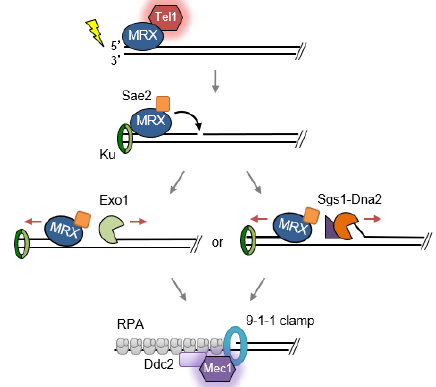
Figure 1. Damage recognition, end resection, and checkpoint activation. The Mre11-Rad50-Xrs2 (MRX) complex detects double-strand breaks (DSBs) and binds to the break ends (only one end is shown). Xrs2 recruits Tel1 and checkpoint signaling is activated. Resection follows a two-step, bidirectional mechanism. MRX, together with its cofactor Sae2, initiates resection by endonucleolytic cleavage of the 5 (cid:48) -terminated strand, generating an entry site for long-range resection machineries, Exo1 and Sgs1-Dna2, to proceed in the 5 (cid:48) to 3 (cid:48) direction. Meanwhile, the MRX complex proceeds back towards the double-stranded DNA (dsDNA) end using its 3 (cid:48) to 5 (cid:48) exonuclease activity. Single-stranded DNA (ssDNA) generated by resection is coated by replication protein A (RPA), which recruits Ddc2 and the Mec1 checkpoint